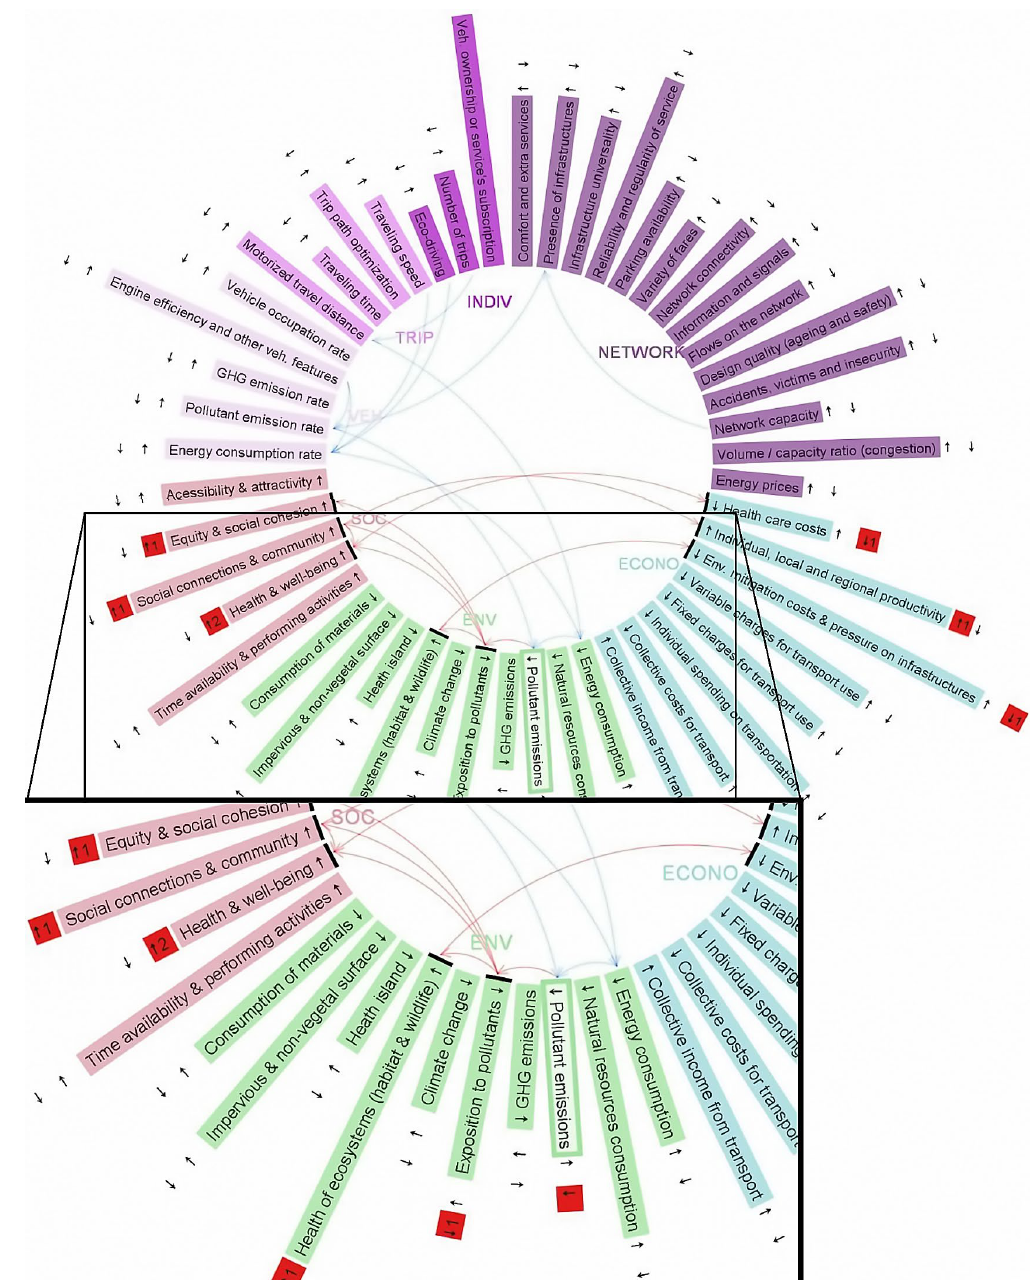
Fig. 3. The Causal circle, reduction of the emissions of pollutants (hierarchy level 2, automobile) (Sioui